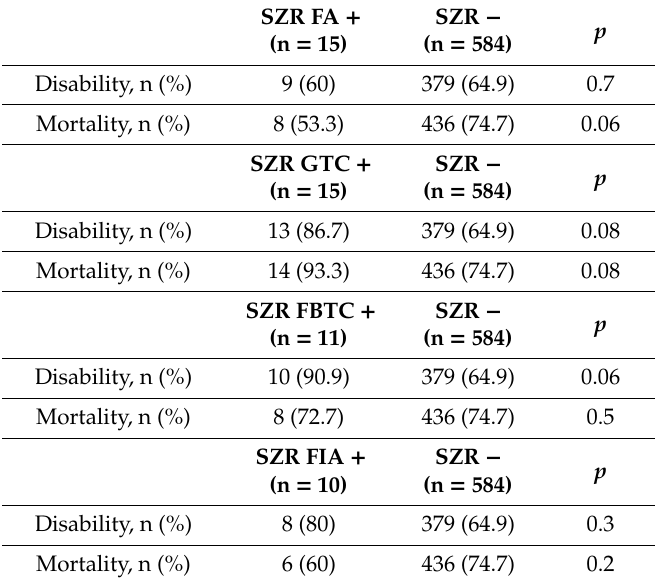
Table 4. Type of seizure and long-term